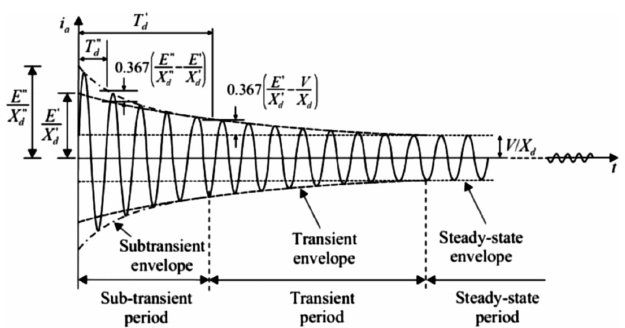
Fig. 8. Evolution of armature current during a short-circuit with a 6th order synchronous machine model